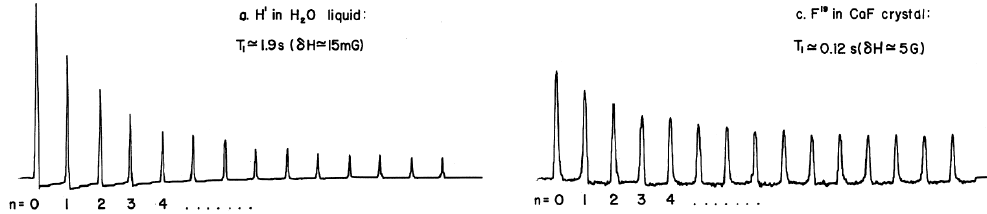
Figure 17. Example traces from the Look and Locker experiment. Each peak is an individual absorption signal collected after n full cycles of the sweep signal showing an exponential reduction in signal amplitude. The left figure is the signal from protons in water, the right figure is the signal from Fluorine in Calcium Fluoride. (reproduced with permission from [43]. Copyright American Physical Society,